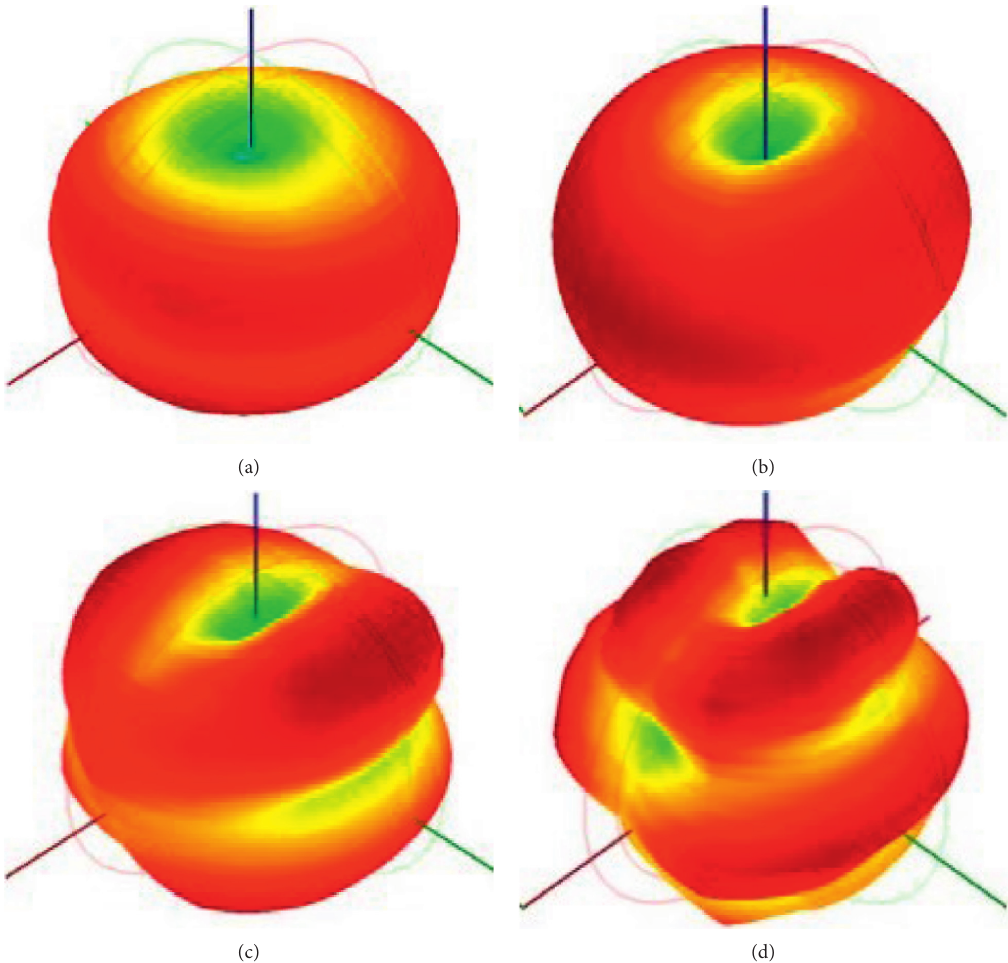
Figure 14: Antenna measurement 3D radiation pattern at (a) 1.6 GHz, (b) 2.35GHz, (c) 3.8GHz, and (d) 5.85GHz.